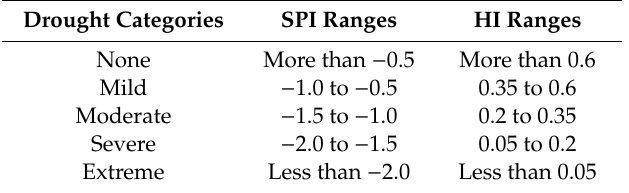
Table 2. Classification scale for SPI and HI and their drought